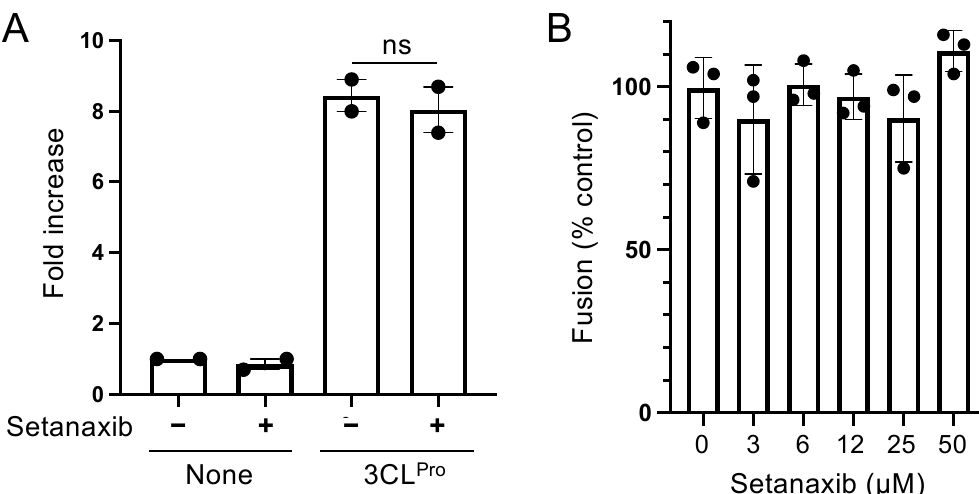
Figure 7. Setanaxib does not affect 3CL Pro activity or viral fusion. ( A ) Huh7.5 cells expressing the 3CL Pro luminescent biosensor were transfected with an expression plasmid that was either empty (None) or encoding SARS-CoV-2 3CL Pro as described in Figure 2. After 5 h of incubation, Setanaxib was added at 25 µ M. After 24 h of culture, luciferase activity in culture wells was determined and normalized to cell viability determined using the CellTiter-Glo reagent. Data correspond to means ± SEM from 2 independent experiments in triplicate and statistical significance was determined by Student’s t -test. ( B ) The potential impact of Setanaxib on membrane fusion induced the S protein of SARS-CoV-2 was determined in a cell-to-cell fusion assay. HEK-293T cells expressing both the S protein and the α peptide of β -galactosidase were co-incubated with HEK-293T cells expressing ACE2 and the Ω peptide of β -galactosidase. Cells were co-cultured for 5 h with increasing concentrations of Setanaxib to permit fusion, and β -galactosidase activity was determined using a bioluminescent substrate. Data correspond to means ± SEM from one experiment in triplicate and statistical significance was determined by Student’s t-test.